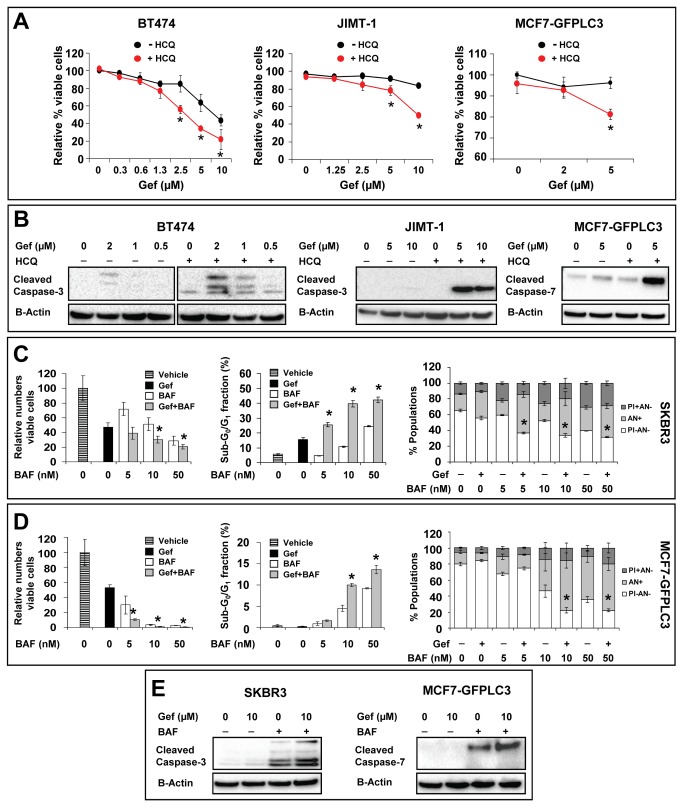
HCQ and bafilomycin A1 sensitize gefitinib-treated cells to cell death.(A) BT474, JIMT-1 and MCF7-GFPLC3 cells were treated for 24 h, 72 h and 168 h, respectively, with vehicle (0 µM gefitinib) or increasing concentrations of gefitinib (Gef) in the absence or presence of HCQ (20 µM). The HCA (BT474 and JIMT-1) and flow cytometric data (MCF7-GFPLC3) are expressed as percentage of viable ETH- or PI-excluding cells, respectively, in the total population normalized to vehicle-treated cells expressed as 100%. (B) Western blot analysis of caspase activation in lysates derived from cells treated as indicated in (A). (C) SKBR3 cells were treated for 72 h and (D) MCF7-GFPLC3 cells were treated for 120 h with vehicle, 10 µM gefitinib (Gef), increasing concentrations of bafilomycin A1 (BAF) and the combination of gefitinib and bafilomycin A1 (Gef+BAF). Left graphs: absolute numbers of viable (trypan blue excluding) cells in cultures treated with the indicated agents relative to cultures treated with vehicle expressed as 100%. Middle graphs: flow cytometric analysis of the sub-G0/G1 cell fraction in cells treated with the indicated agents (mean±SD, n = 3). Right graphs: flow cytometric analysis of apoptosis and viability based on Annexin V-Alexa647 and PI staining. PI+AN-: necrotic cells; AN+: apoptotic cells; PI-AN-: viable cells. Each data point in (A), (C) and (D) represents a mean±SD from 3 replicate samples. Asterisks indicate a significant difference (p<0.05) between cells treated with gefitinib and the combination of gefitinib and HCQ in the same category. The results shown are representative of 2 experiments for each cell type. (E) Western blot analysis of caspase activation in lysates derived from SKBR3 and MCF7-GFPLC3 cells treated for 72 h and 120 h, respectively, with vehicle or gefitinib (Gef) in the absence or presence of 10 nM bafilomycin A1 (BAF).